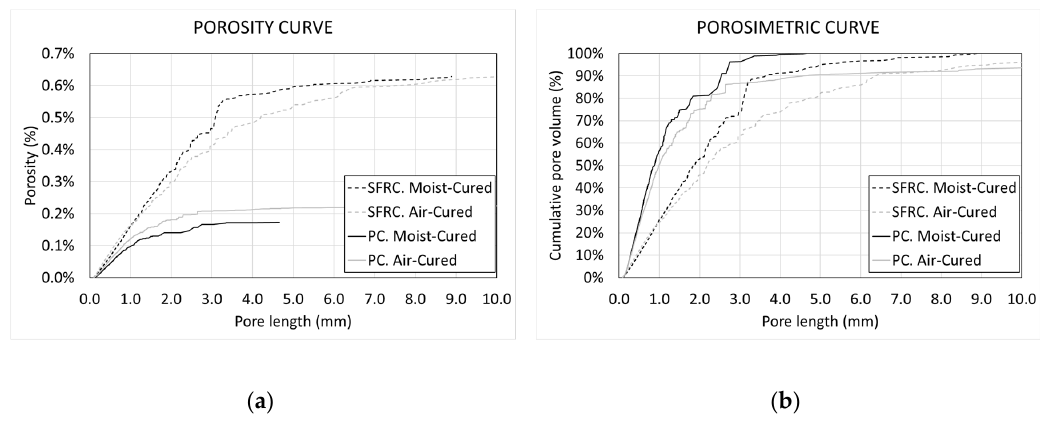
Figure 7. ( a ) Pore volume curves and ( b ) porosimetric curves.